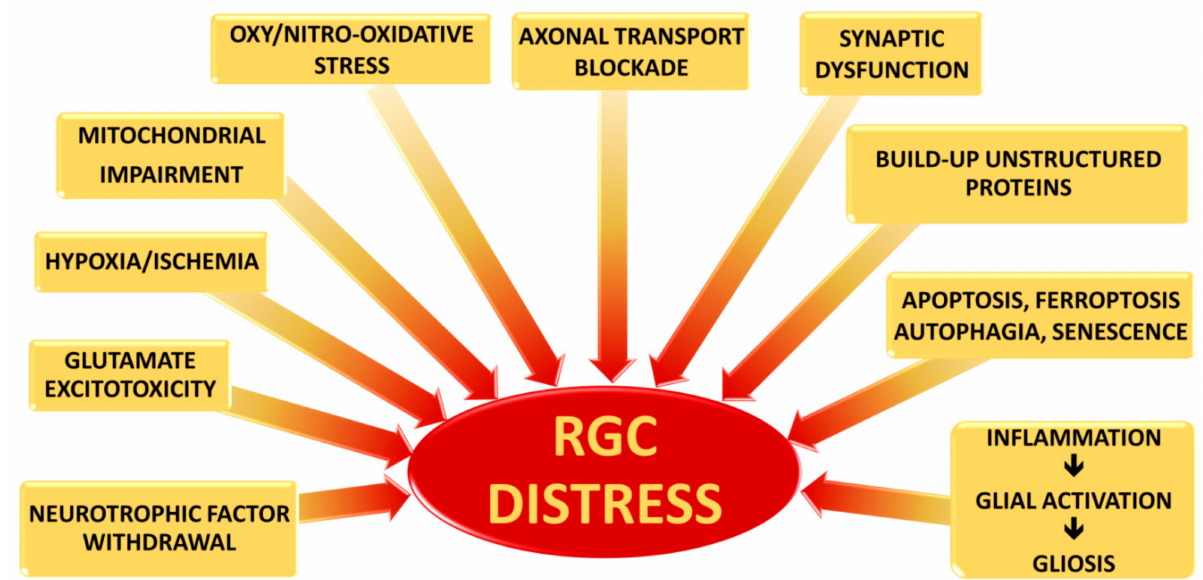
Figure 1. Risk factors contributing to RGC distress in glaucoma: the mechanisms implicated in RGC damage include deficiency in neurotrophic elements, glutamate excitotoxicity, hypoxia and ischemia, impairment of mitochondria functions, oxidative and nitrosative stress, alterations in axonal transport and in synaptic signals, unstructured proteins, apoptosis and other death mechanisms which can lead to premature senescence, and inflammation cascade which induce the activation of glial cells with consequent gliosis.The pathways, triggered by each risk factor, often result to be strictly interrelated, contributing to amplifying RGC distress in an irreversible